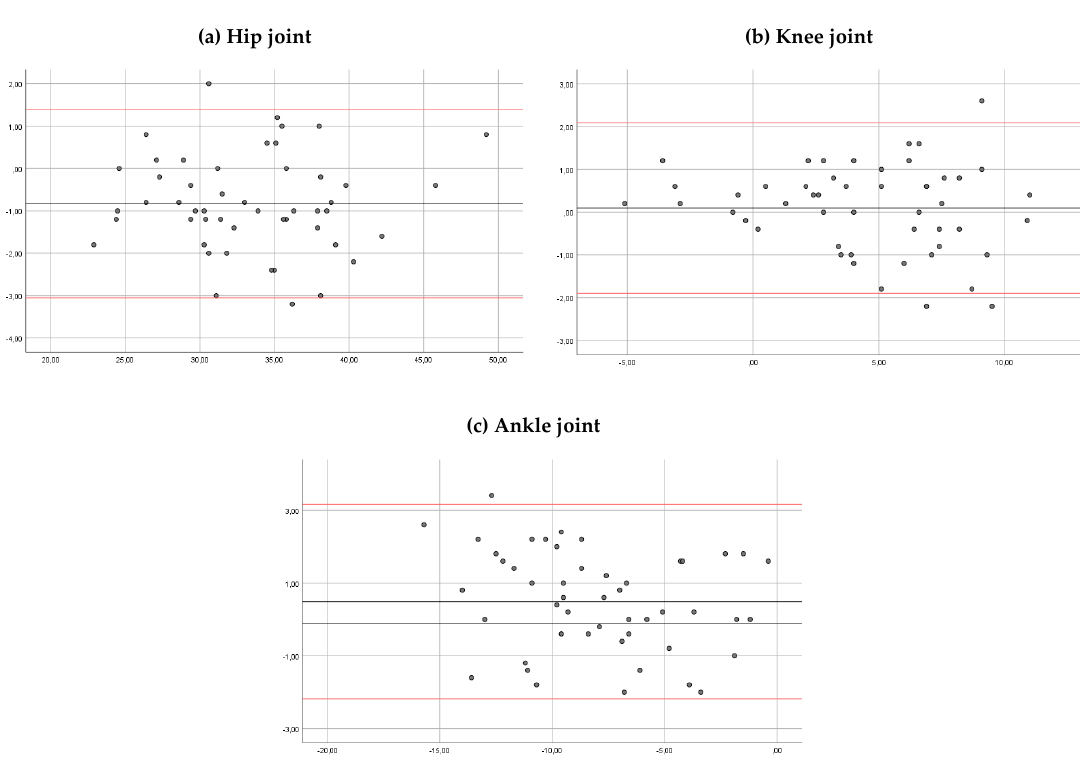
Table 3. Validity of the Kinovea parameters.